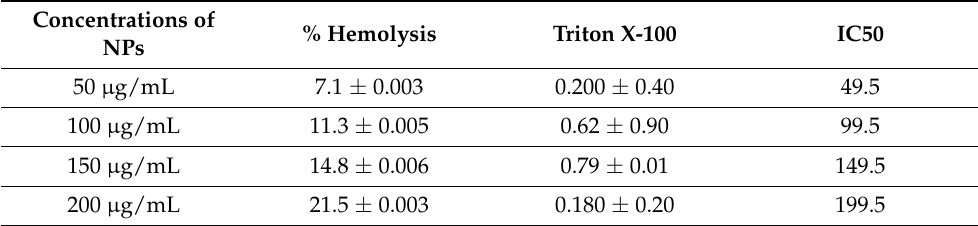
Figure 10. Biocompatibility potential of IONPs against human red blood cells RBC. Table 4. IC 50 and hemolysis values for biocompatibility